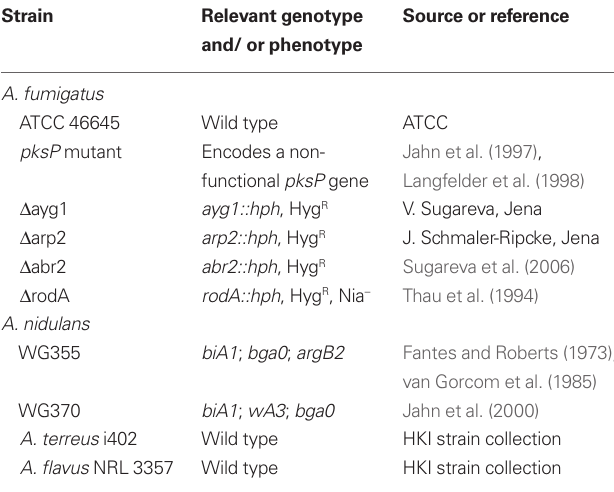
Table 1 | Strains used in this